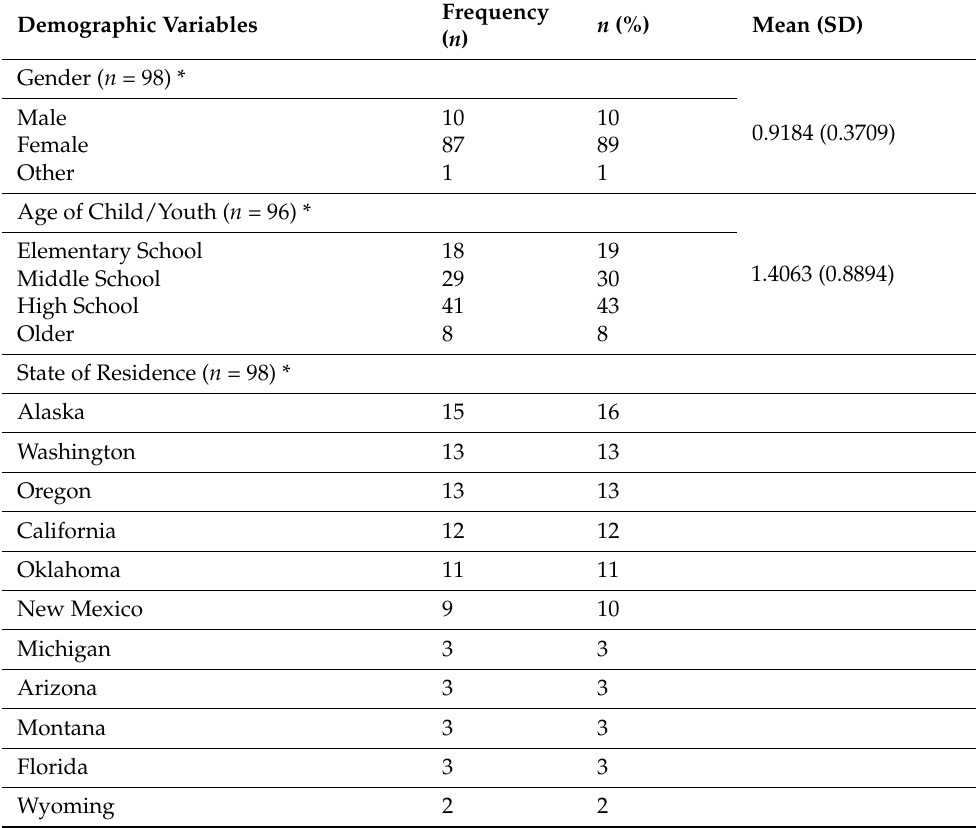
Table 2. Demographic Characteristics of Talking is Power